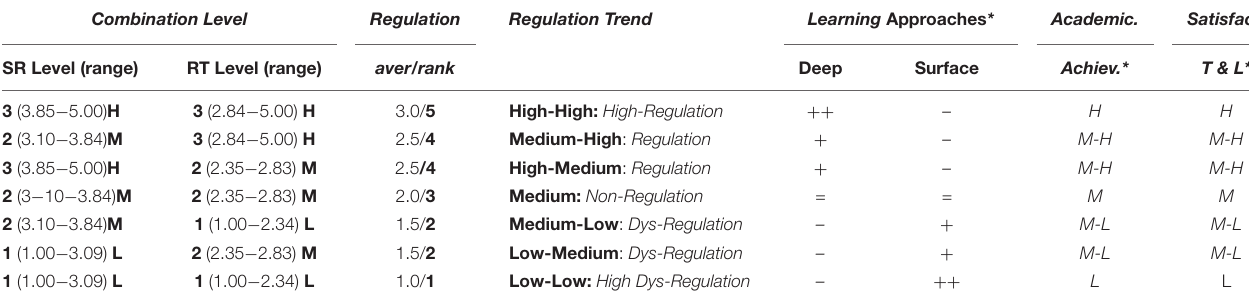
TABLE 1 | Heuristic of five combinations of the Utility Model TM hypothesized by SRL vs. ERL Theory (de la Fuente, 2017). Combination